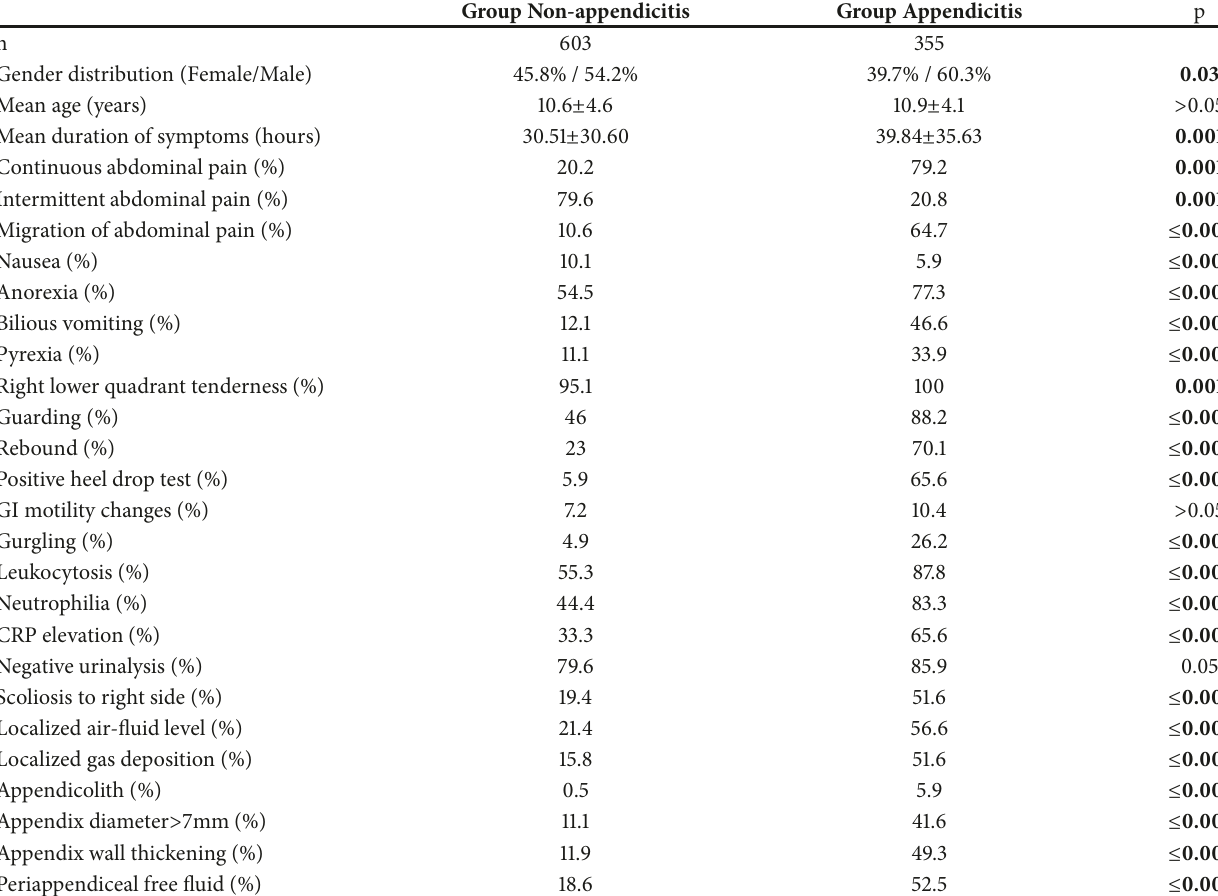
Table 1: Comparison of patient characteristics and findings between study groups (GI: gastrointestinal, CRP: C-reactive